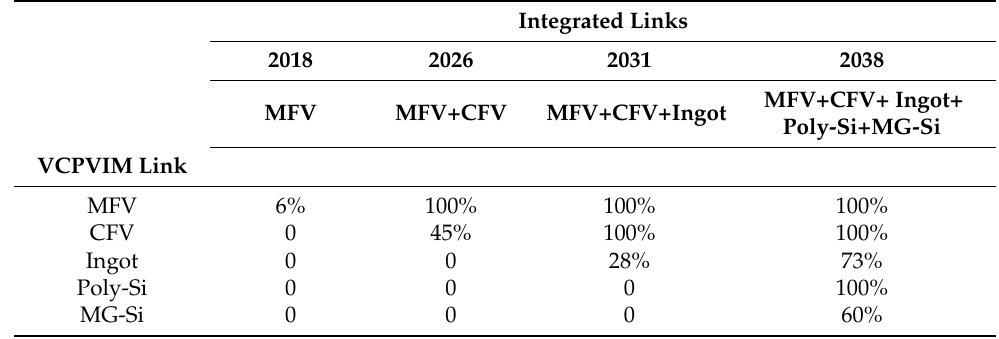
Table 12. Proportion of materials and supplies of national origin in the manufacture of the final products of each link of the VCPVIM in the Alternative Scenario.